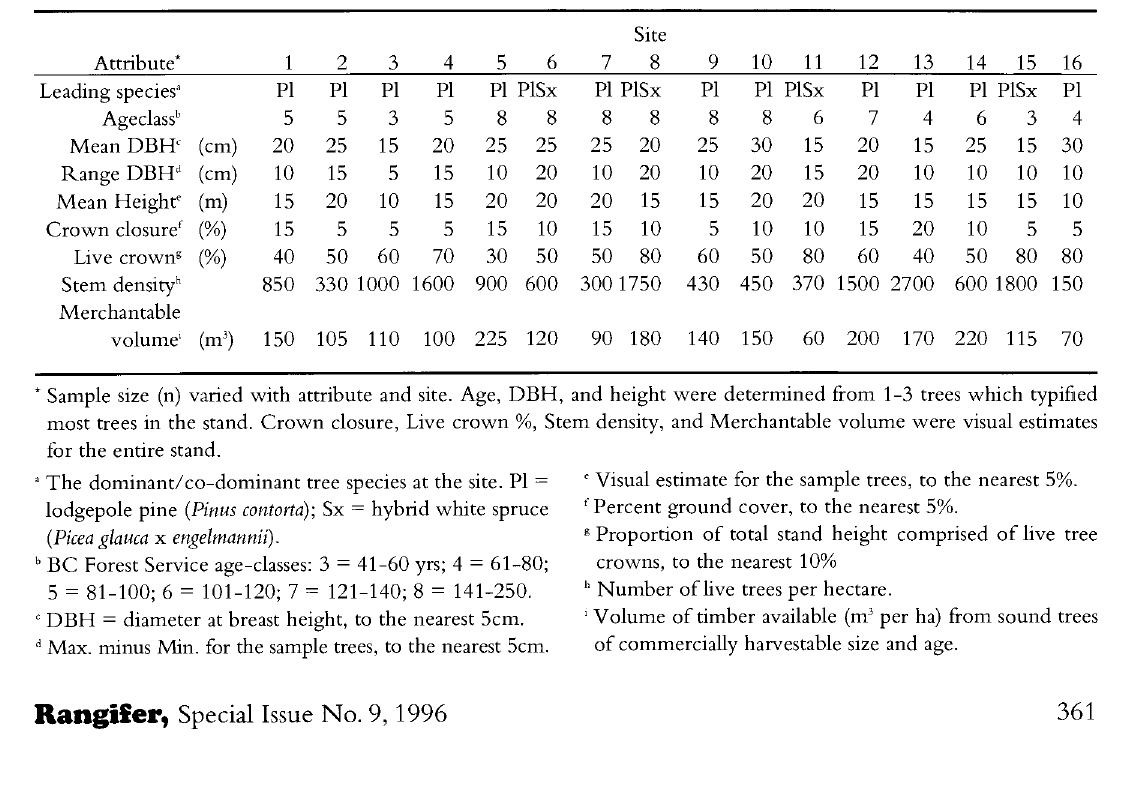
Table 2. Tree attributes at the sample sites.